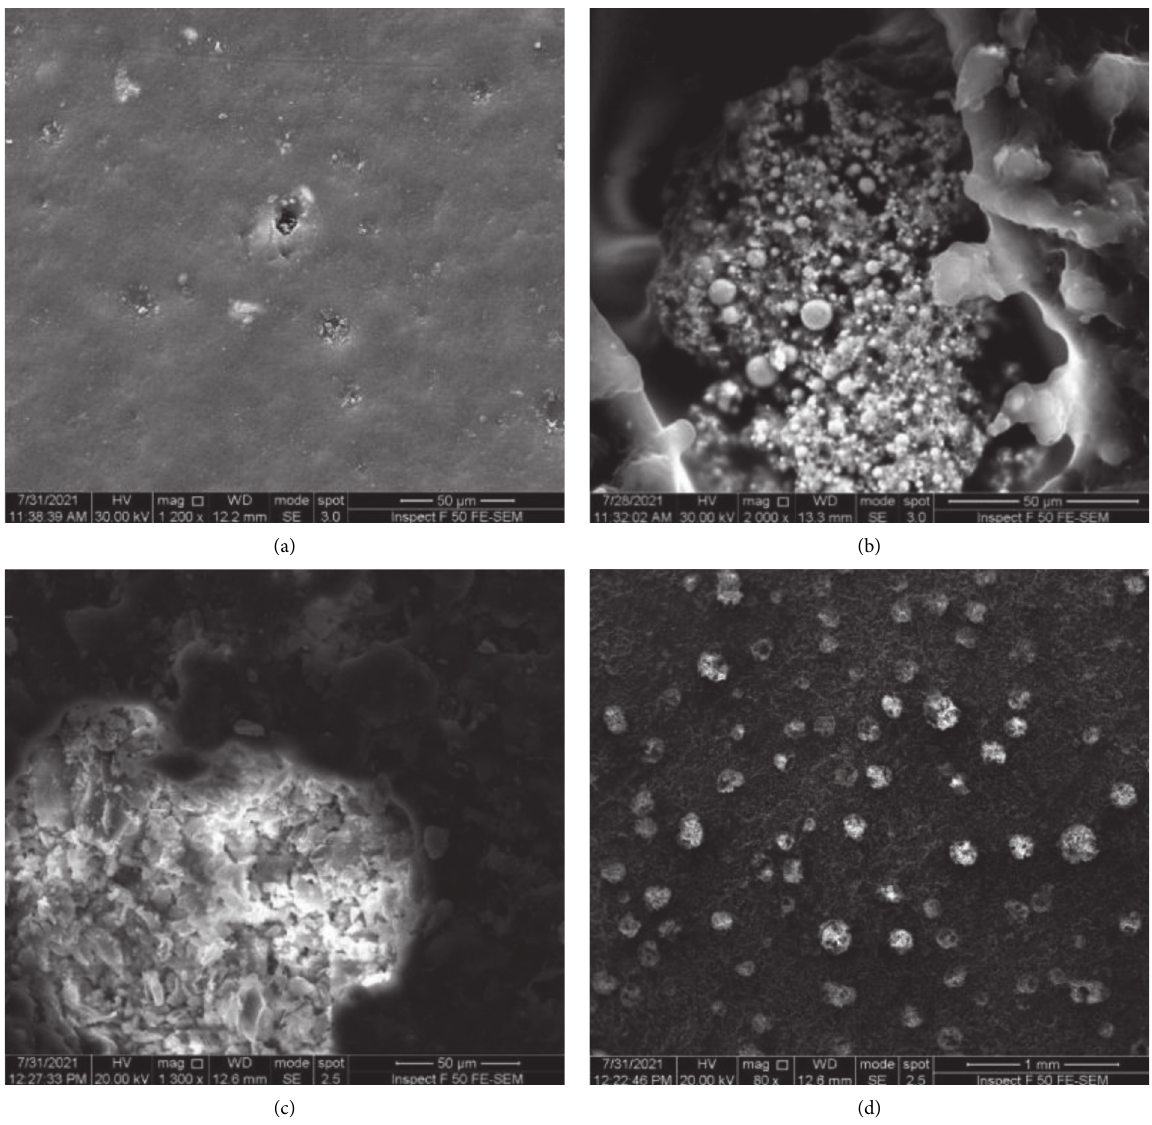
Figure 1: SEM micrographs of (a) bare bioepoxy (b) bioepoxy/1wt% Al2O3-AgNps naocomposite, and (c, d) bioepoxy/3wt% Al2O3-AgNps nanocomposite at various magnifications. Scale bar (a-c) � 50 µ m, (d) �